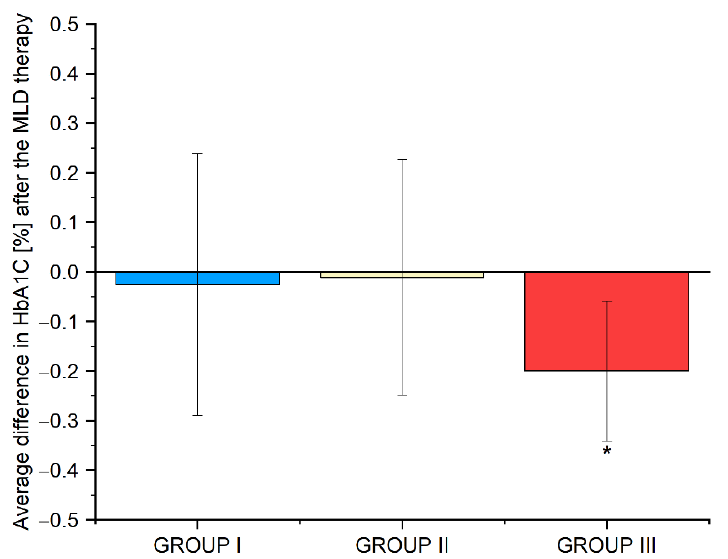
Figure 4. Average differences in HbA1c levels in groups I, II and III before and after the use of MLD